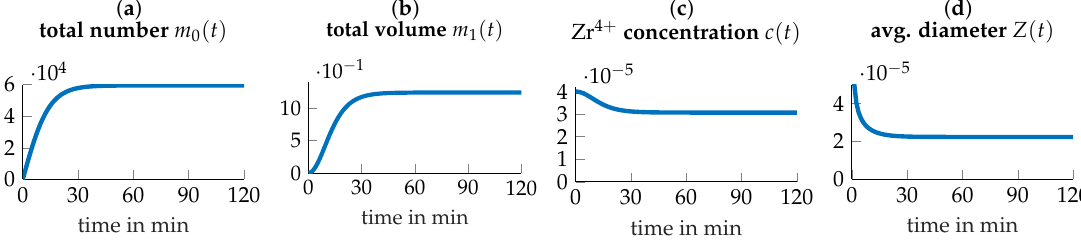
Figure 6. Trajectories of the system under optimized conditions ˆ T = 45.8 ◦ C and ˆ C = 40m M